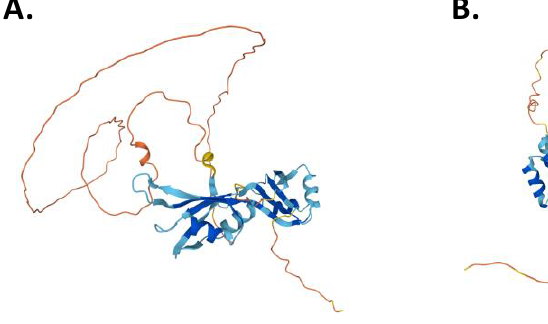
Deletion in AML